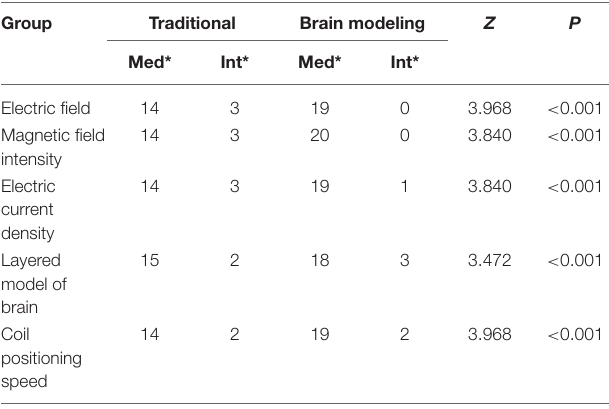
TABLE 5 | Comparison of the mean score of clinical assessment between the brain model teaching group and the traditional teaching group.